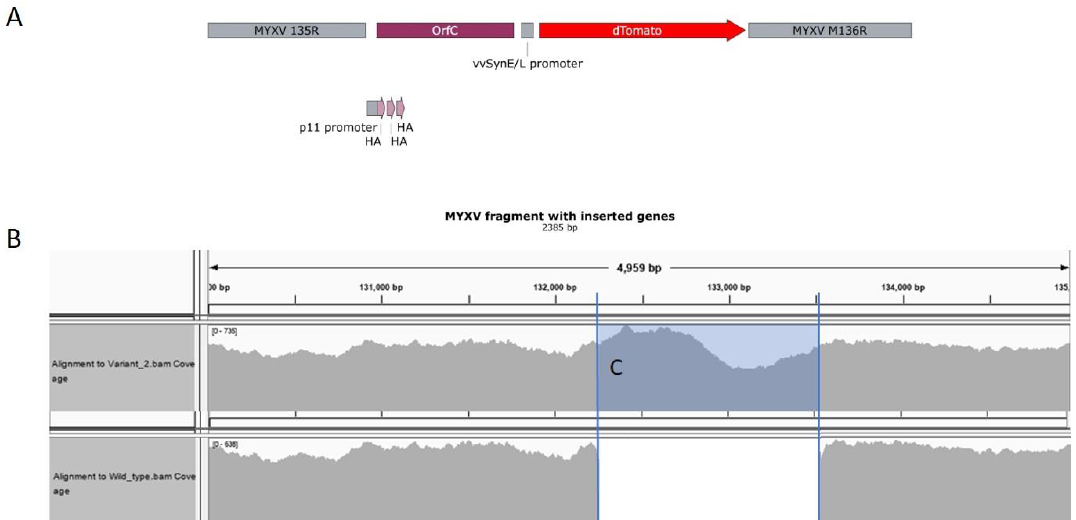
Figure 2. Design and sequence analysis of MYXVorfC. ( A ) Diagram (SnapGene, GSL Biotech, San Diego, CA, USA) of the PCR product that was transfected into MYXV-infected RK-13 cells. ( B ) Alignment of the sequence maps from 130,000–135,000 bp in purified recombinant MYXVorfC DNA as compared to MYXV (AF170726.2) using next generation sequencing. The number of times each nucleotide was read by the sequencer is represented in gray. ( C ) The expected PCR insert was successfully recombined into MYXV to create MYXVorfC. Wild-type MYXV sequence was not detected in the purified MYXVorfC virus sample.